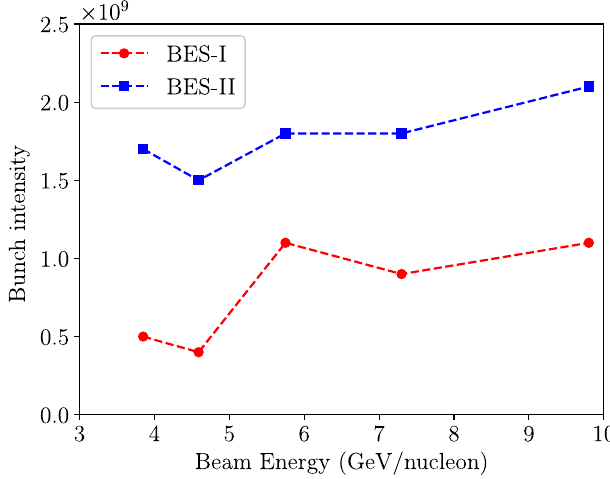
FIG. 18. The bunch intensity during BES-I and BES-II at various beam energies.